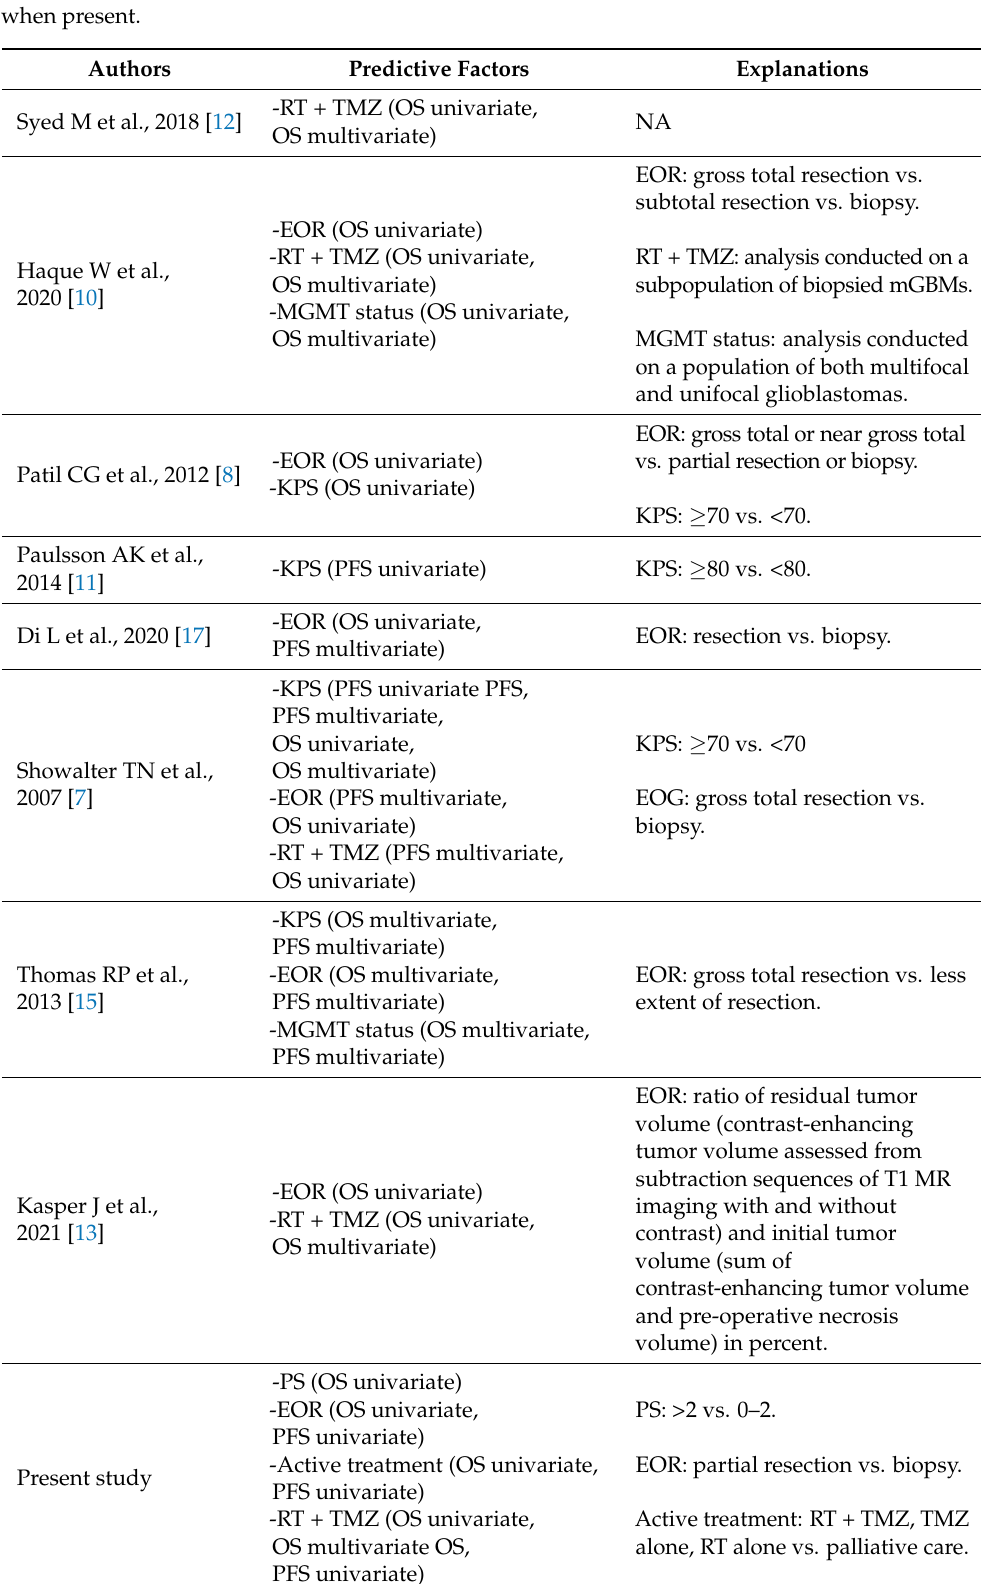
Table 7. Significant prognostic factors affecting survival in mGBM patients. Explanations are reported when